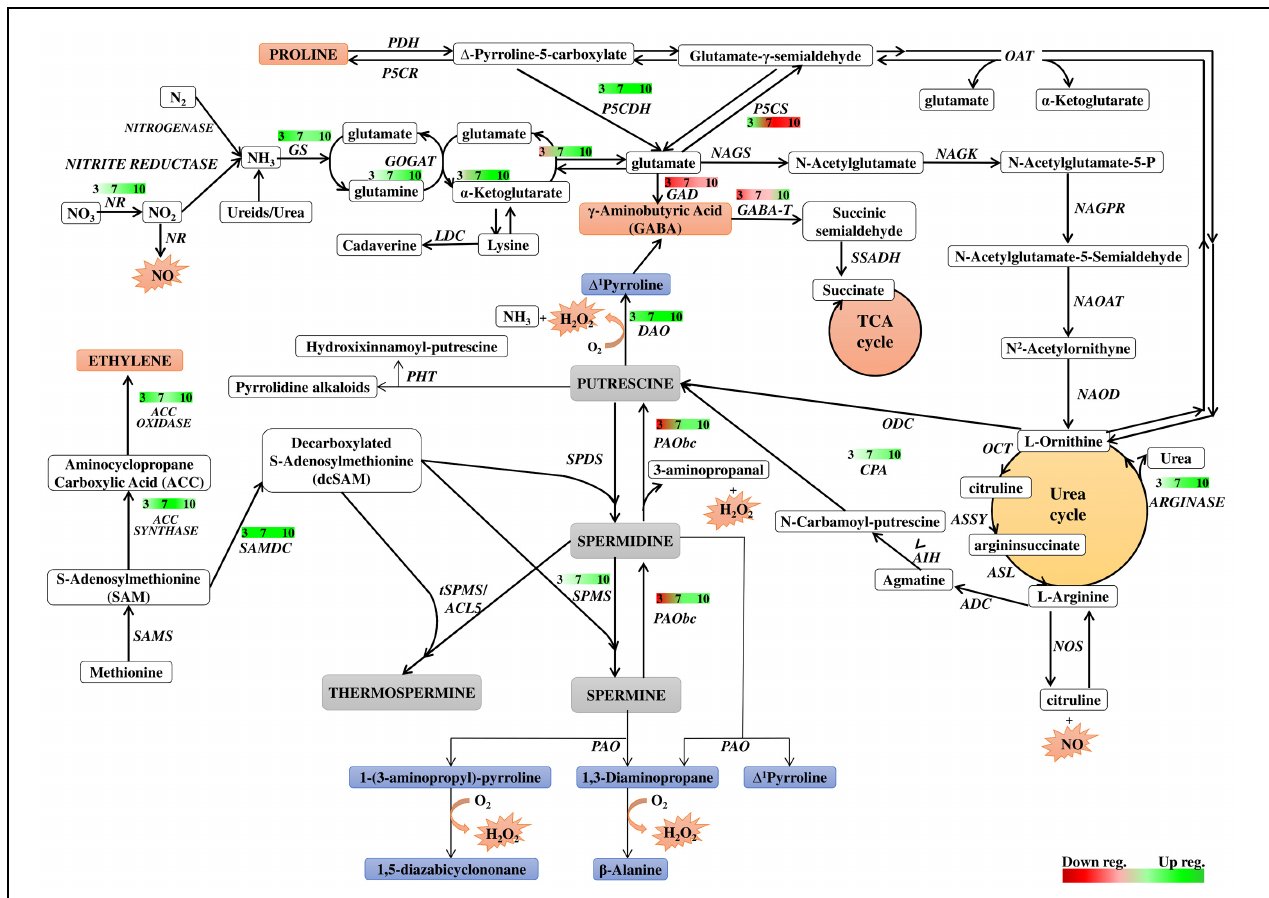
FIGURE 8 | Schematic presentation of possible interaction between polyamine metabolism and other pathways through dark-induced barley leaf senescence. Polyamine biosynthetic routes are indicated with bolded lines. Thin lines mark putrescine-derived alkaloid formation, polyamine conjugation and catabolic processes. The red-green bars indicate the expression level of genes estimated according to the results of microarray analysis. Numbers in the bars describe the senescence days. NR, nitrate reductase; GS, glutamine synthetase; GOGAT, glutamine oxoglutarate aminotransferase; NAGS, N -acetylglutamate synthase; NAGK, N -acetylglutamate kinase; NAGPR, N -acetylglutamate 5-phosphate reductase; NAOAT, N -acetylornithine transaminase; NAOD, N 2 -acetylornithine deacetylase; OCT, ornithine carbamoyltransferase; ASSY, argininosuccinate synthase; ASL, argininosuccinate lyase; ADC, arginine decarboxylase; AIH, agmatine iminohydrolase; CPA, N -carbamoylputrescine amidohydrolase; ODC, ornithine decarboxylase; SAMS, SAM synthetase; SAMDC, SAM decarboxylase; SPDS, spermidine synthase; SPMS, spermine synthase; tSPMS/ACL5, thermospermine synthase/acaulis5; PAO, polyamine oxidase; PAObc, back conversion polyamine oxidase; SSAT, spermidine/spermine N -1 acetyl transferase; DAO, diamine oxidase; GABA-T, γ -aminobutyrate aminotransferase; SSADH, succinic semialdehyde dehydrogenase; GAD, glutamate decarboxylase; PHT, putrescine hydroxycinnamoyl transferase; LDC, lysine decarboxylase; NOS, nitric oxide synthase; P5CS, (cid:2) 1 pyrroline-5-carboxylate synthetase; P5CR, (cid:2) 1 pyrroline-5-carboxylate reductase; PDH, proline dehydrogenase; P5CDH, (cid:2) 1 pyrroline-5-carboxylate dehydrogenase; OAT, ornithine- δ